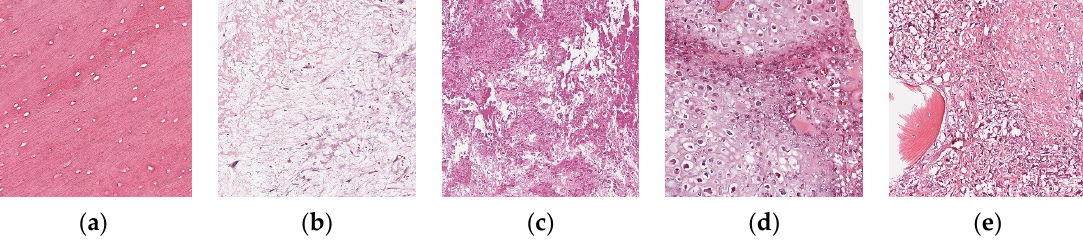
Figure 14. Examples of the osteosarcoma histology images. ( a ) Non-tumor; ( b , c ) necrotic tumor; ( d , e ) viable tumor. Table 9. The construction of the osteosarcoma histology image dataset.